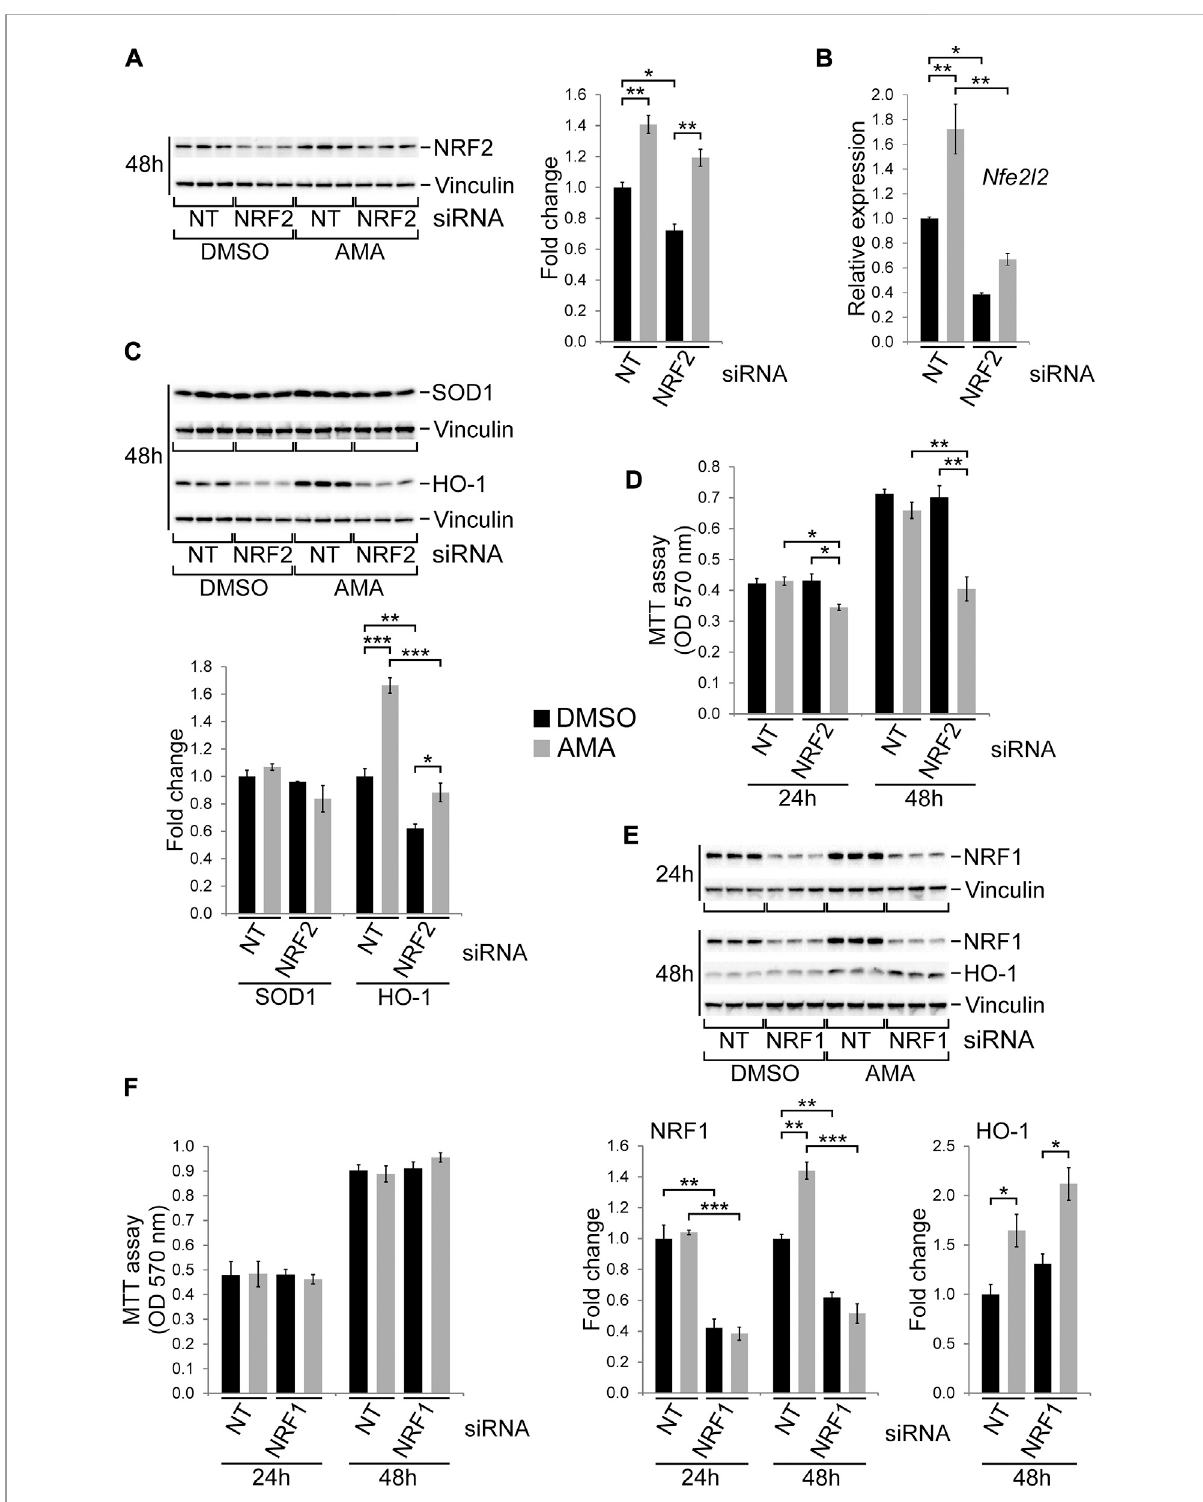
NRF2 is required for growth and survival of H9c2 cells upon antimycin A treatment. (A) Western blots showing protein expression of NRF2 in H9c2 cells transfected with non-target (NT) or NRF2 siRNA and subsequently treated with DMSO or AMA (50 µM) for 48 h. (B) qRT-PCR analyses showingRNAexpressionofNfe2l2,thegeneencodingNRF2,inH9c2cellstreatedasoutlinedin (A) . (C) Westernblotsshowingproteinexpressionof the NRF2 target genes HO-1 and SOD1 in H9c2 cells treated as outlined in (A) . (D) MTT assays of H9c2 cells transfected with non-target (NT) or